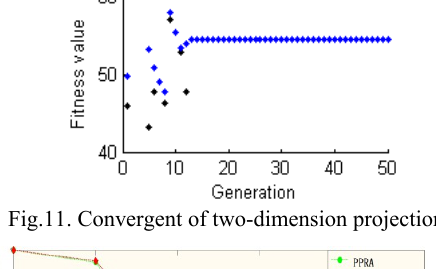
Fig.11. Convergent of two-dimension projection